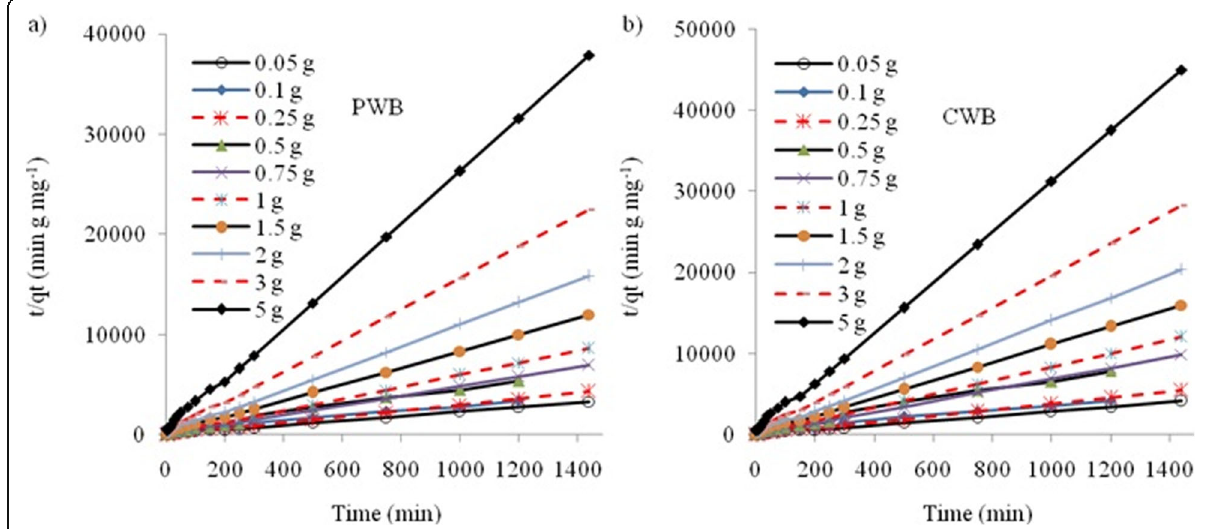
Fig. 2 Linearized pseudo second-order kinetics for adsorption of Pb onto PWB ( a ) and CWB ( b